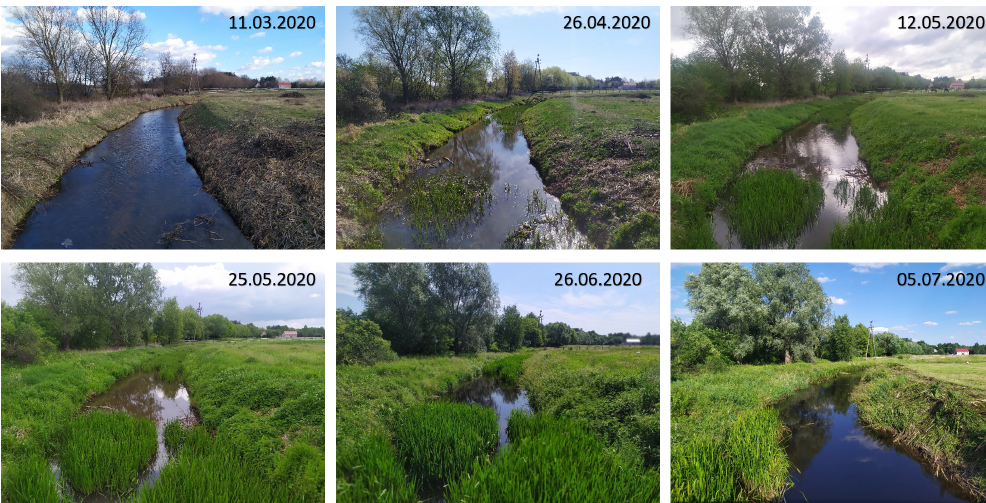
Figure 2. Selected photos of the vegetation photo monitoring conducted in the Warszawicki Channel during 2020. Pictures show the situation from the winter conditions – before vegetation started to grow (left top image) until the channel maintenance cleaning in summer (right bottom photo). The monitoring was carried out as part of the BRITEC citizen science project (https://britec.igf.edu.pl/, last access: 28 February 2023). Photos taken by pupils from the primary school in Warszawice.